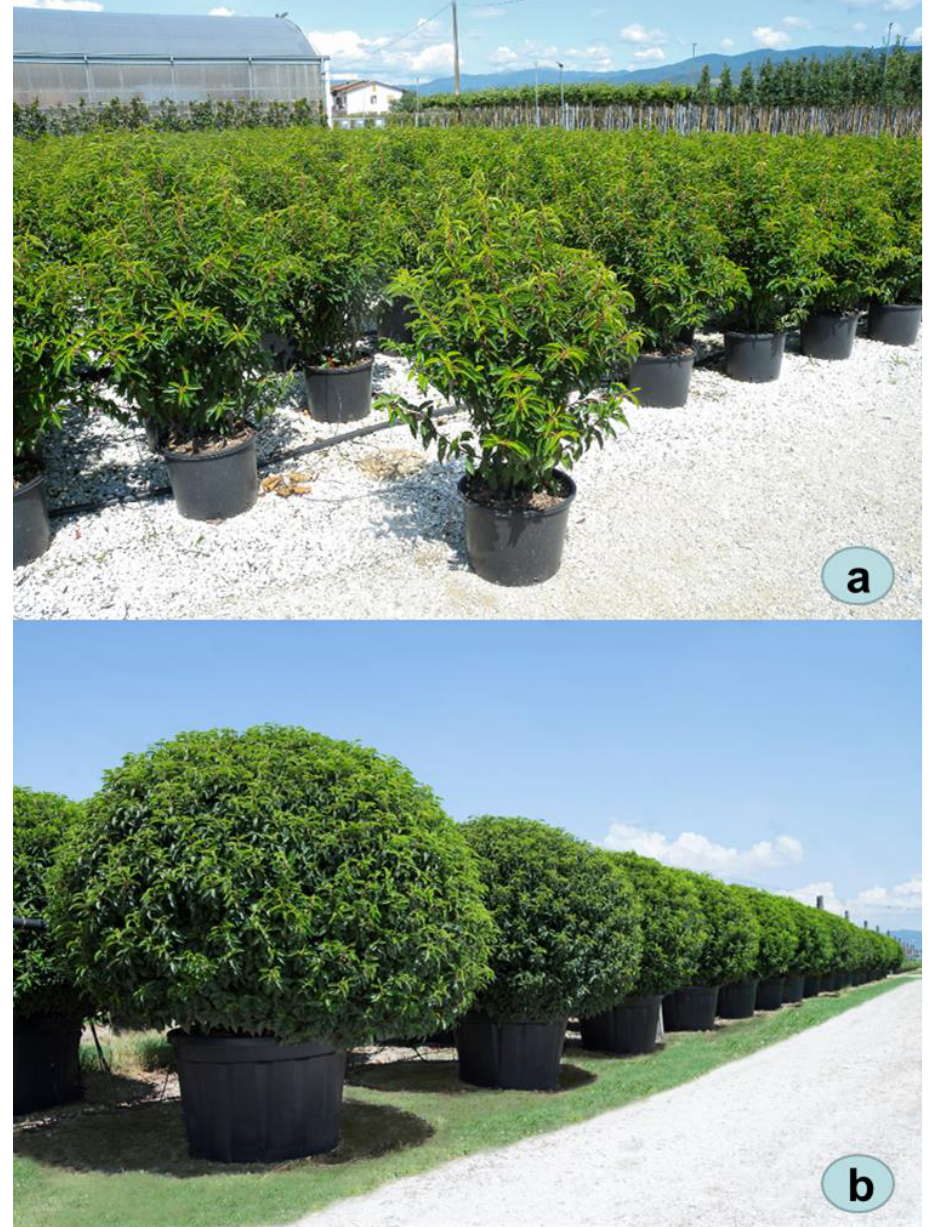
Figure 1. Potted Prunus lusitanica plants growing in a nursery: ( a ) hedging plants and ( b ) topiary balls.